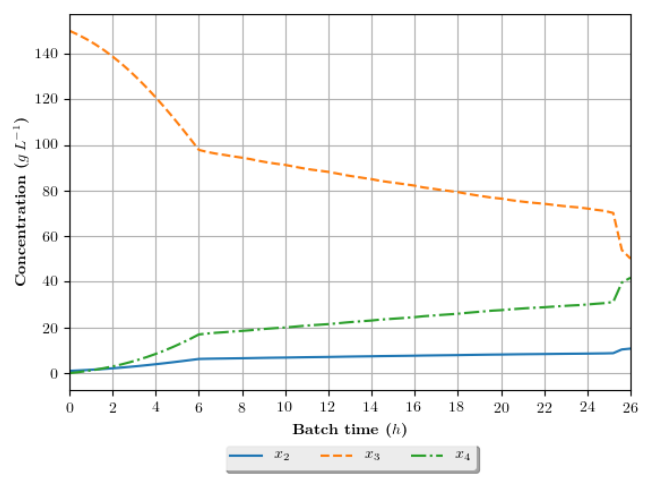
Figure 11. Growth profile for the assay of number 16 (2h/DE/cos—2h interval between DRTO cycles, DE as the optimization algorithm and cosinoidal feed rate parametrization), in terms of the concentration of cellular biomass ( x 2 ), substrate ( x 3 ) and ethanol ( x 4 ) during the